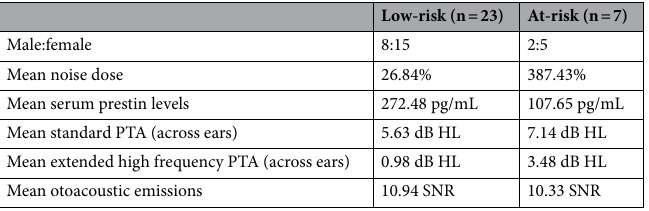
Table 2. Mean serum prestin levels, noise exposure, and audiometric measures, by group. PTA pure tone